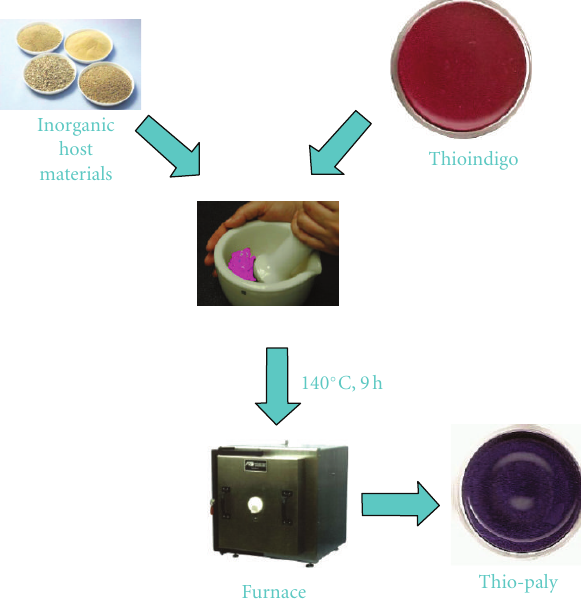
Figure 3: Color change of clay/dye complex during synthesis, in this case